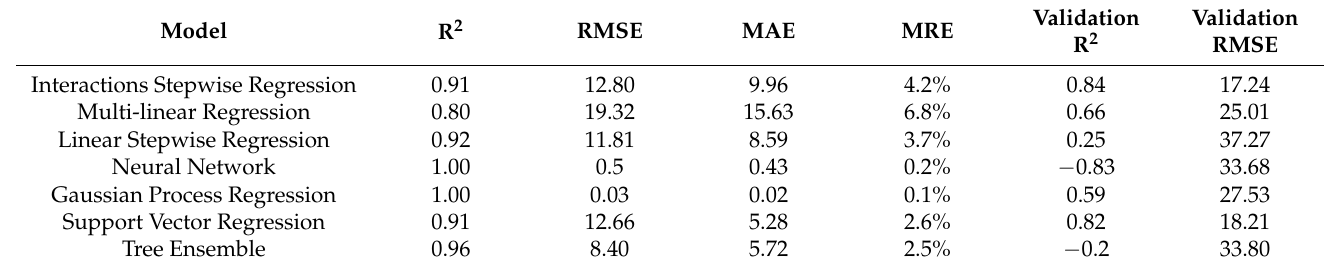
Table 4. Tested algorithms to fit the specific throughput